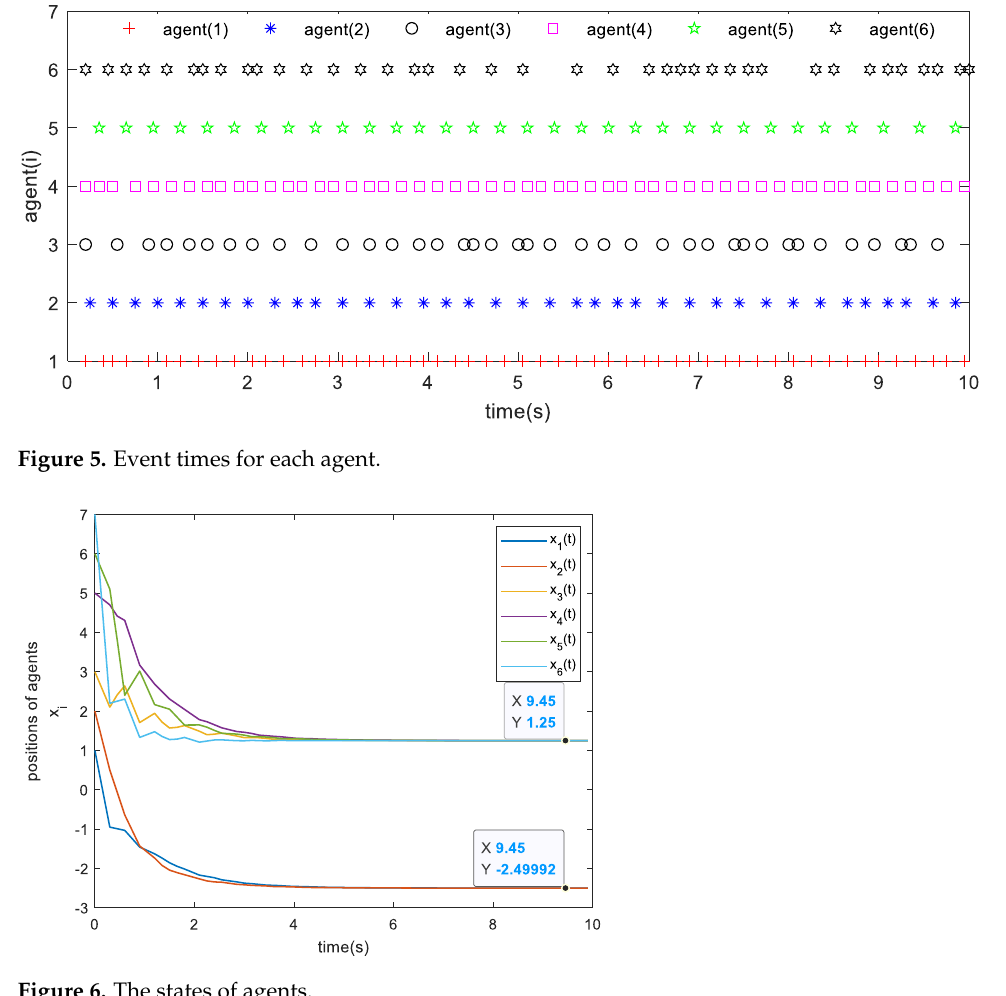
Figure 4. Evolution of error signals for each agent.